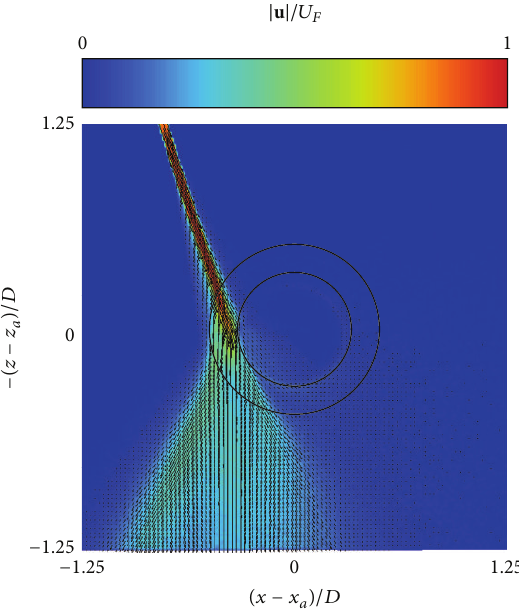
Figure 13: Time-averaged velocity distribution when 𝜆 = 0.7 .